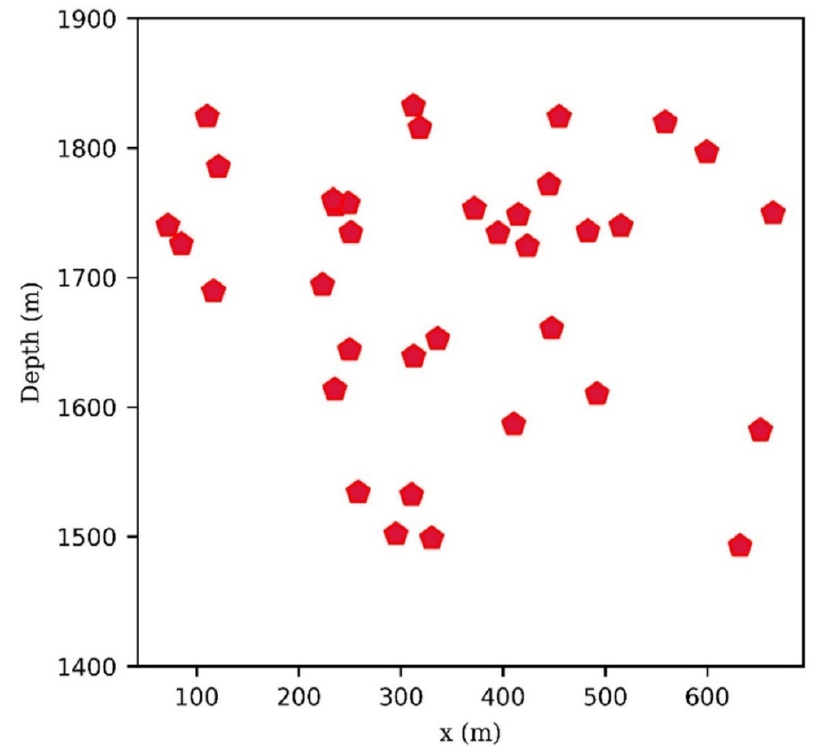
Figure 14. The 2-D section view projection of the inverted locations of the microseismic events from the FORGE data.